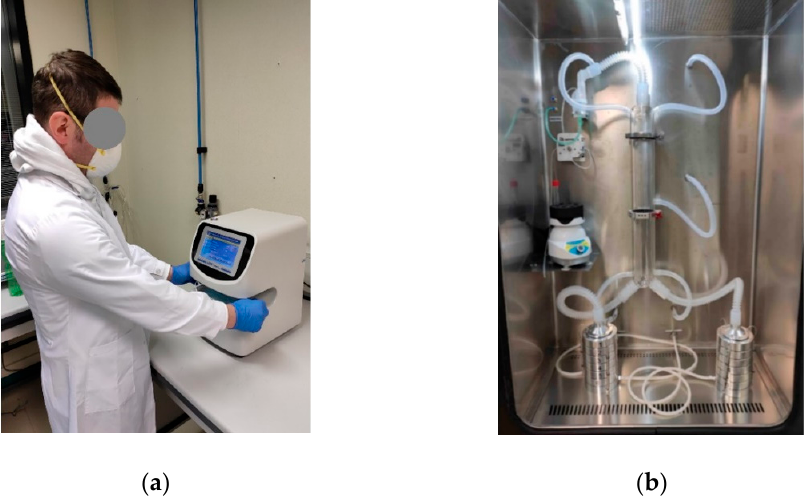
Figure 1. The test system for Differential Pressure (DP) ( a ) and Bacterial Filtration Efficiency (BFE) ( b ) at Università Politecnica delle Marche (UNIVPM) and Università di Camerino (UNICAM). UNIMORE collaborated with Safe s.r.l. (Mirandola, Italy), a private laboratory specializing in biological and chemical analysis.